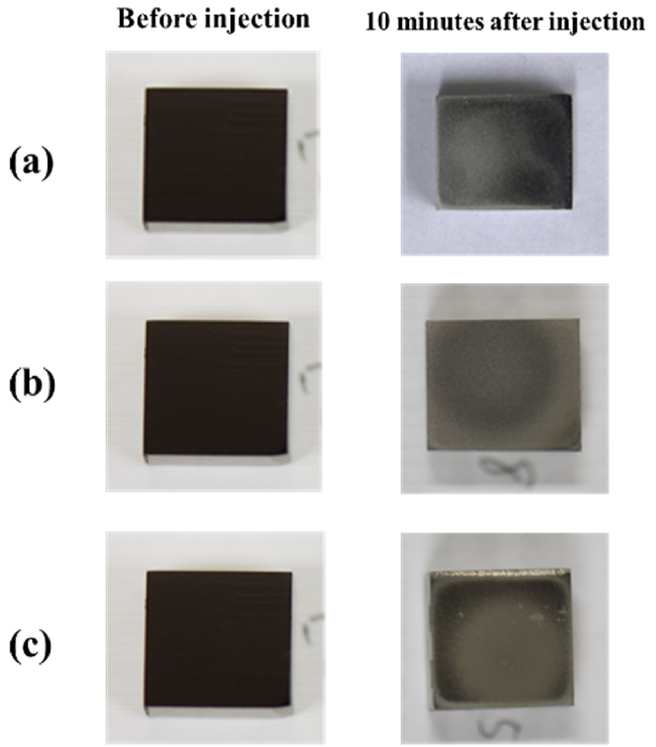
Figure 4. Images of the titanium surface before and after 10 s blasting of β -TCP ( a ), CaCO 3 particles ( b ), and white alumina particles ( c ).